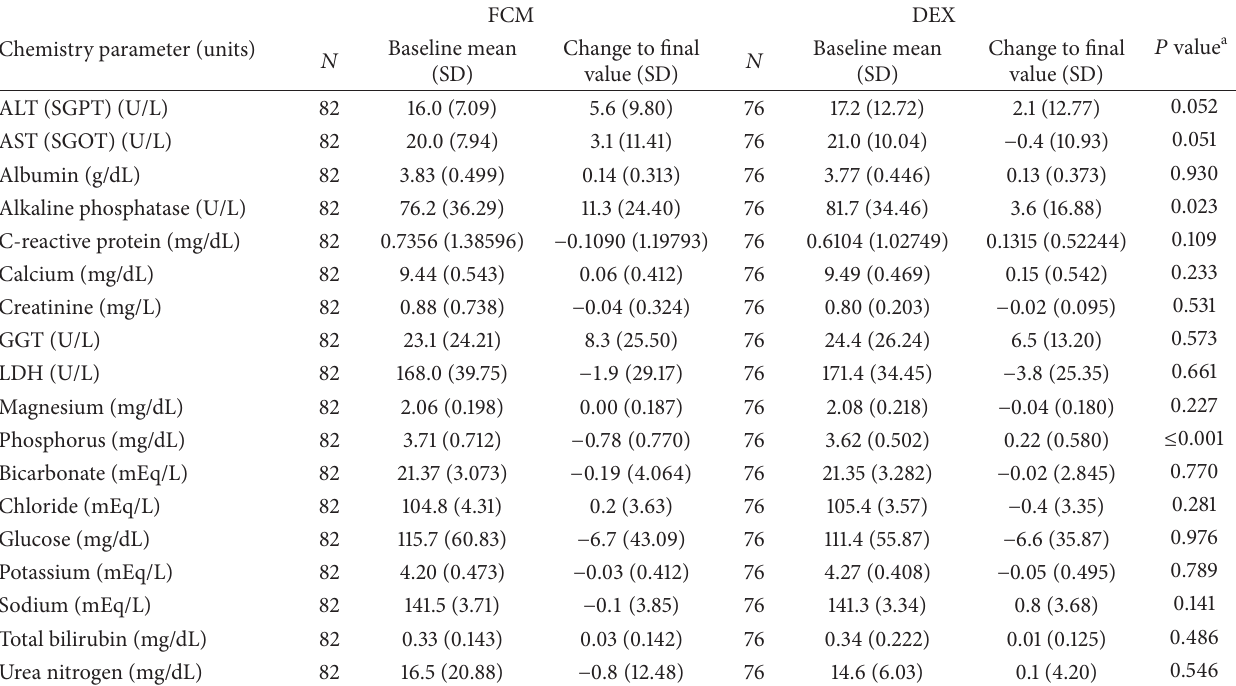
Table 5: Changes in laboratory values.